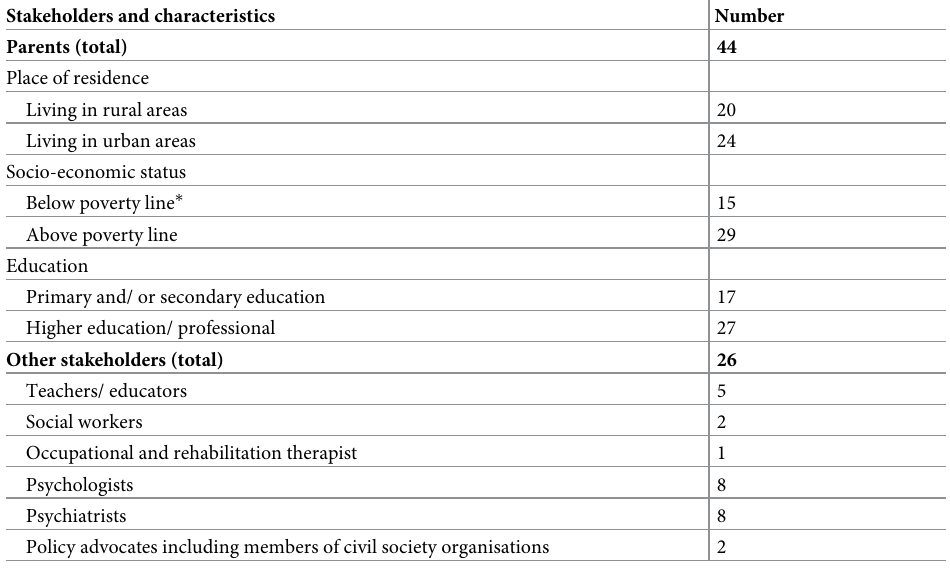
Table 1. Characteristics of stakeholders who participated in the three rounds of